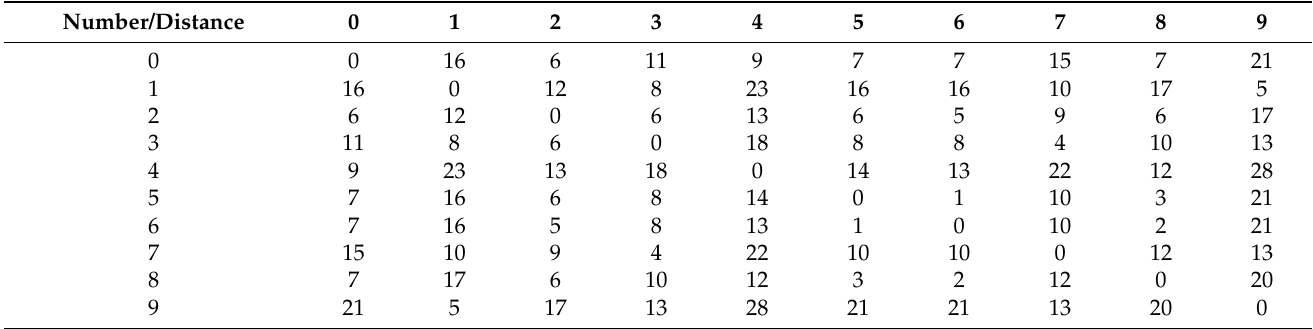
Table 7. Distance matrix between the distribution center and the demand